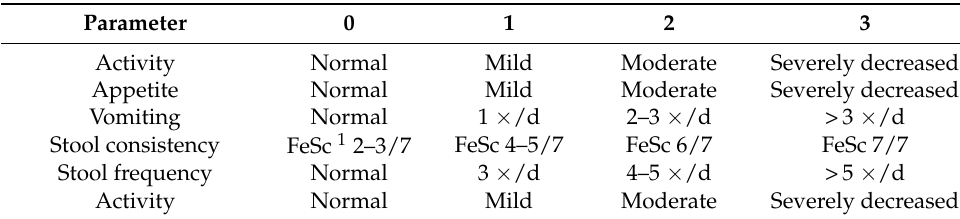
Table 2. Scoring system of the Canine Acute Diarrhea Severity Index.